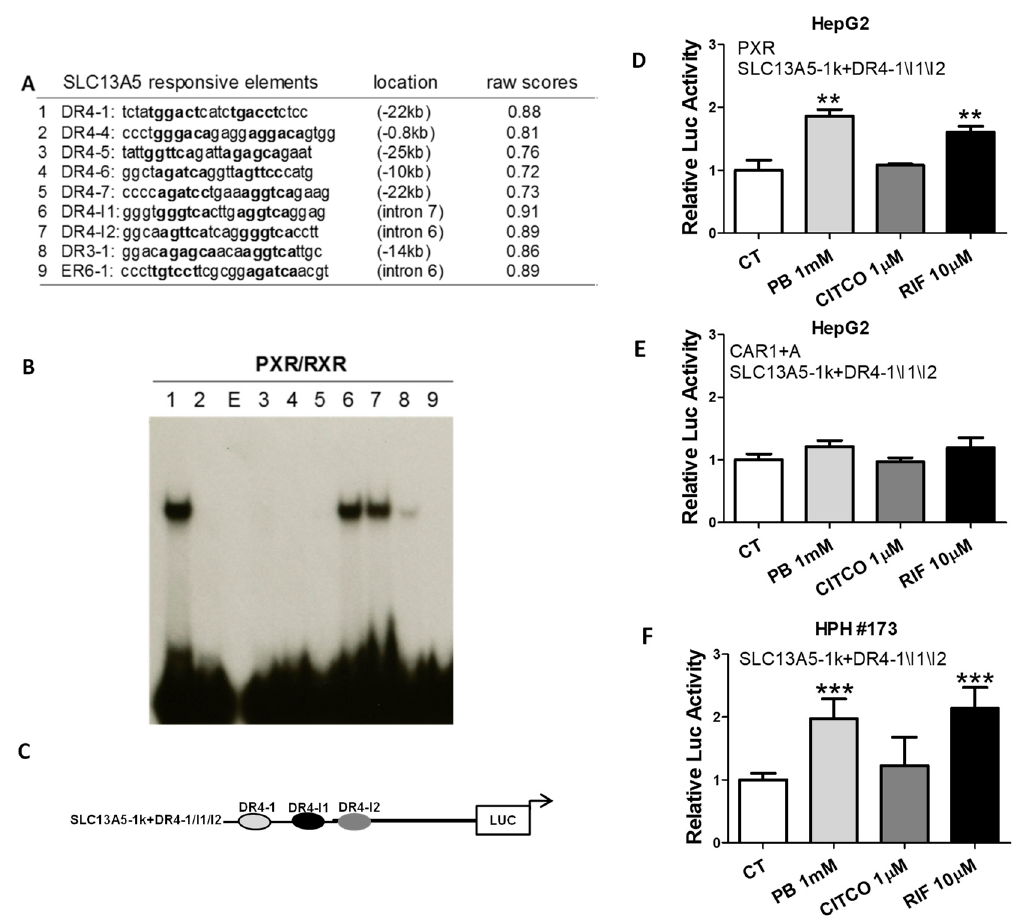
Figure 5. Identification of PXR-response elements in the upstream and introns of SLC13A5 gene. ( A ) Nine PXR-response elements were identified in the upstream and introns of SLC13A5 gene. ( B ) In vitro binding of the predicted DR4, DR3, and ER6 elements with PXR/RXR α heterodimer was measured using electrophoretic mobility shift assays. Lanes 1–9 represent elements summarized in Table A; E: empty lane. ( C ) Schematic illustration of the SLC13A5 reporter construct,